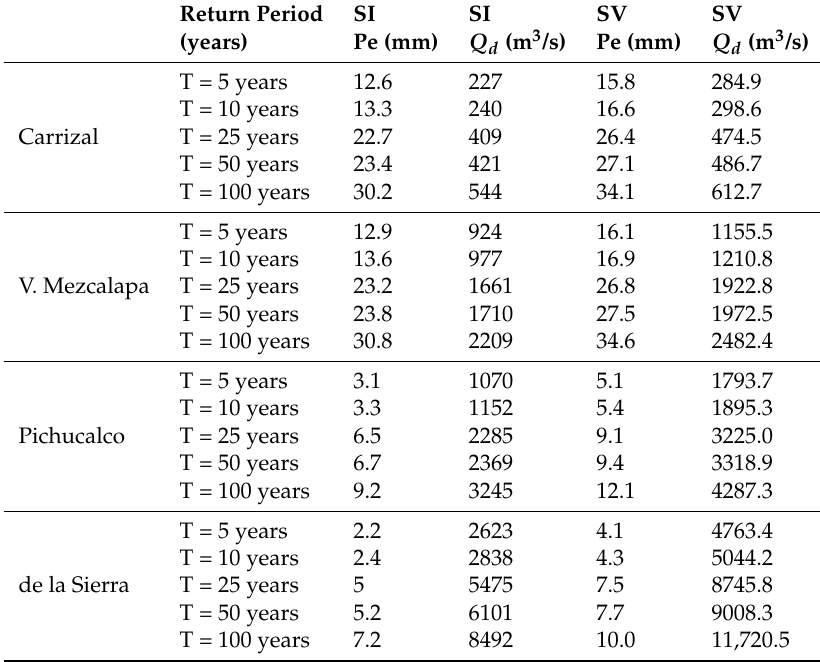
Table 4. Excess precipitation depths and flood discharges estimated for every basin and each